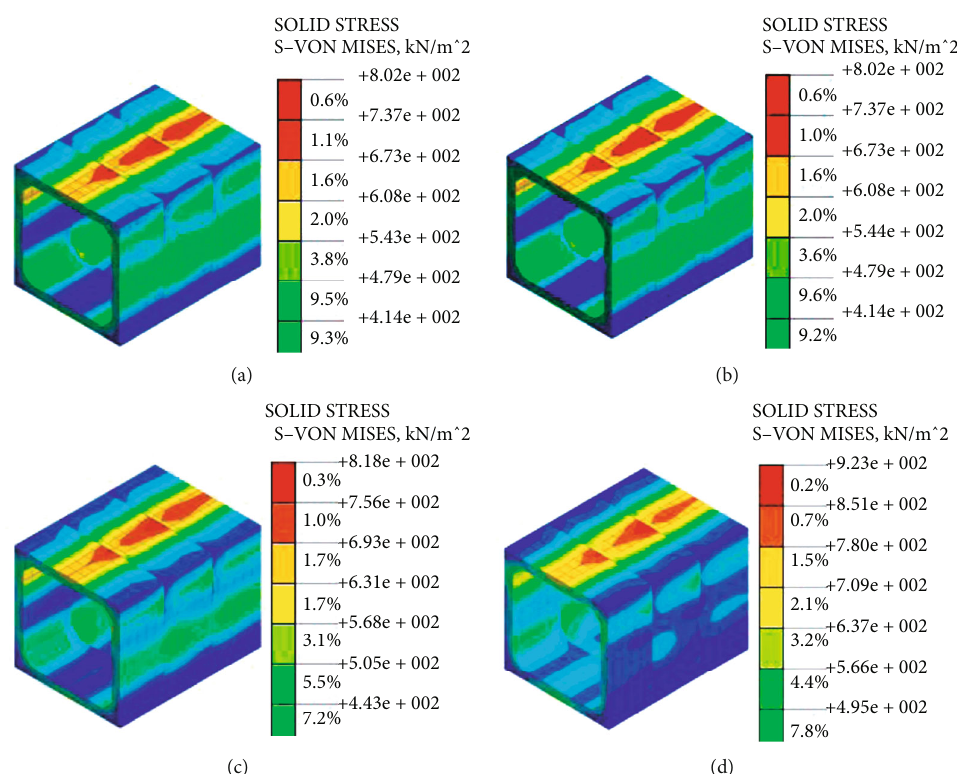
Figure 13: The overall Mises stress cloud map of the integrated pipe gallery under di ff erent groundwater levels. (a) When the water level is at d4. (b) Rises from d4 to d3. (c) Rises from d3 to d2. (d) Rises from d2 to